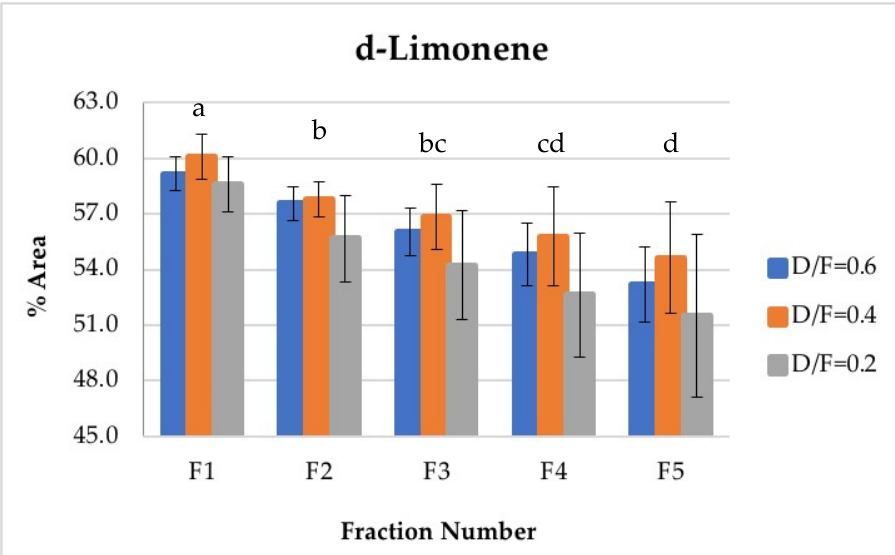
Figure 7. Abundance profile vs. number fraction for d-limonene. The results are the average of three replicates ± standard deviation. Different letters over a column indicate statistical differences (Tukey, p < 0.05).